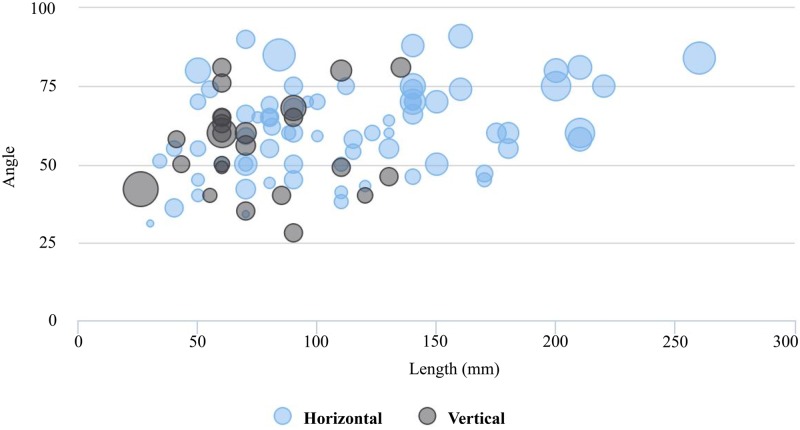
Dihedral functioning according to tool functioning direction (TFD).Bubbleplot of edge length and angle weighted by weighted and grouped by TFD (mm = millimeters).